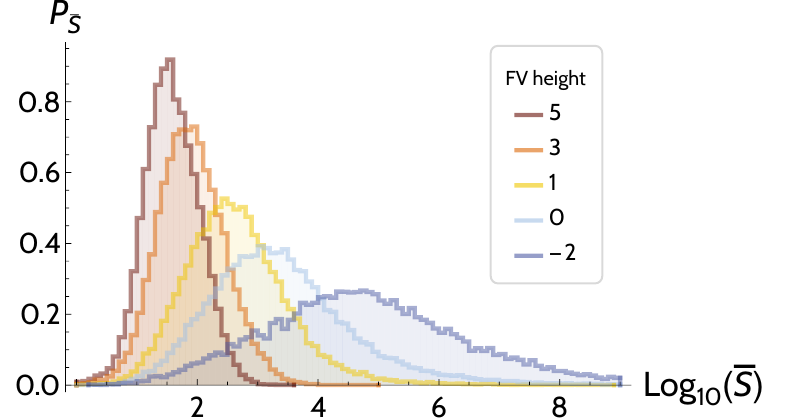
Figure 5. Obtained distribution of tunneling action ( (cid:22) S ) in terms of false vacuum height. (cid:12)eld space by the di(cid:11)erent instanton decay channels. 8 We have only considered tunneling